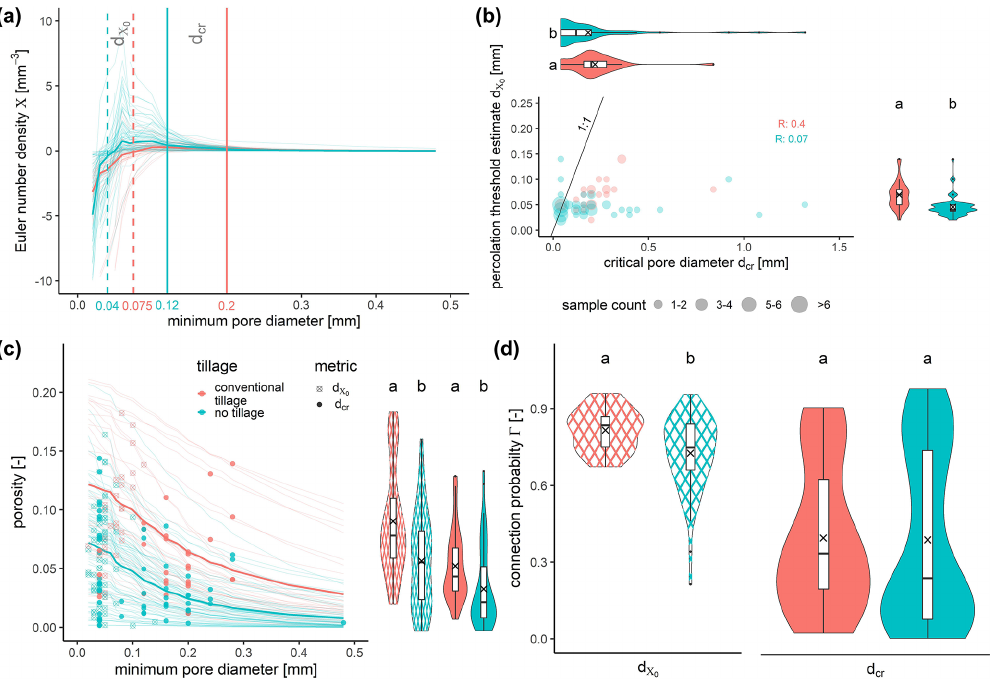
Figure 3. Connectivity metrics to analyze characteristic pore morphologies imposed by different tillage treatments: (a) Euler number density as a function of minimum pore diameter for all investigated samples. The vertical lines mark the median pore diameters where intrinsic connectivity (dashed lines) and long-range connectivity (solid lines) is lost. (b) Relationship between d cr and d χ and treatment statistics. (c) Cumulative pore size distribution and the pore volume where d cr and d χ samples or as treatment statistics. (d) Connection probability (cid:48) at d cr and d χ differences ( p < 0 . 05, Wilcoxon rank sum